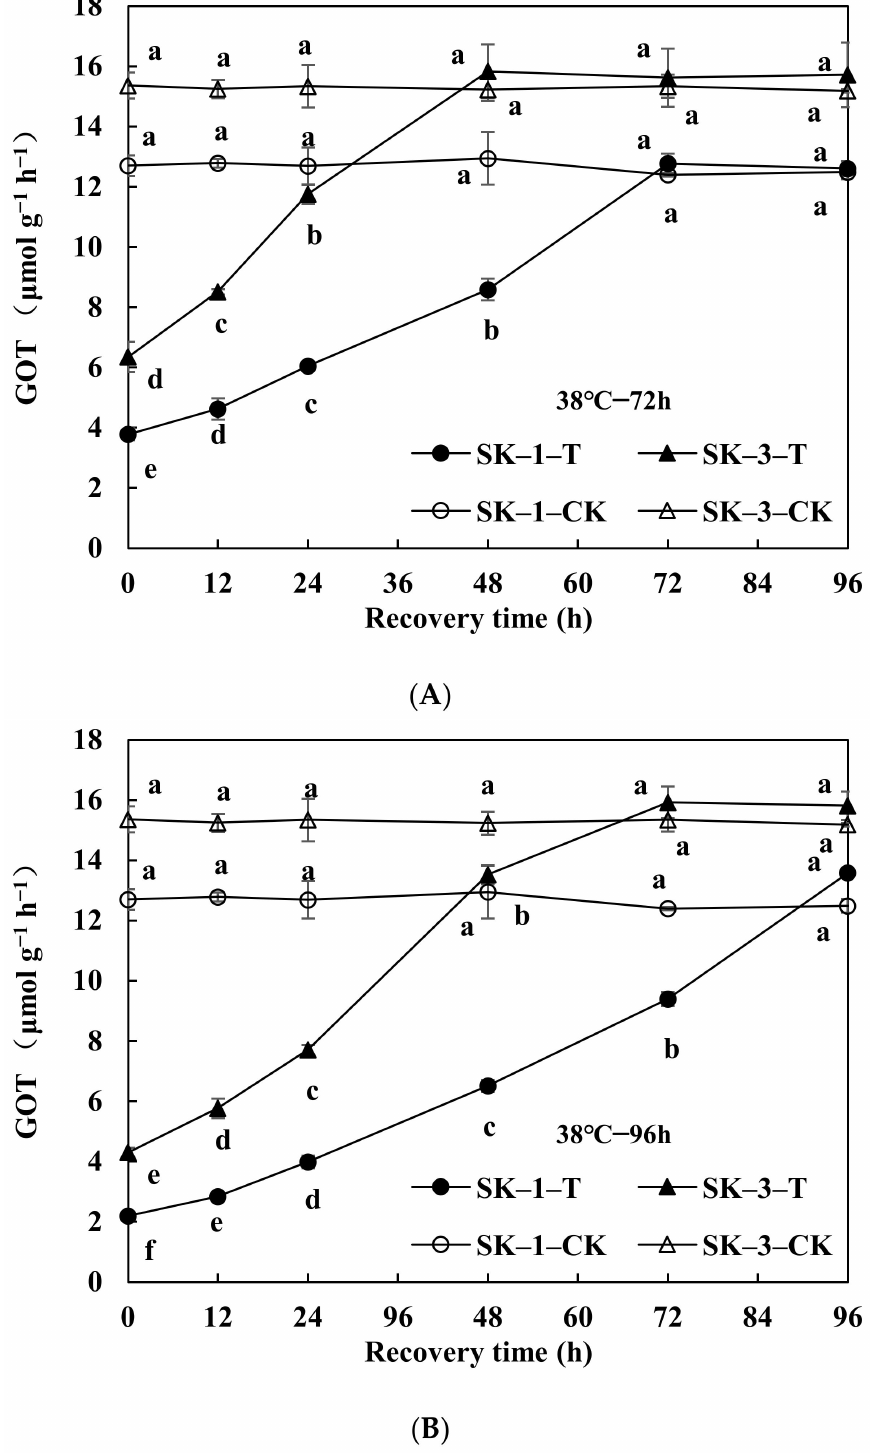
Figure 4. Changes in GOT activities in squares of Bt cotton after 72 h ( A ) and 96 h ( B ) high-temperature stress termination. GOT activity at the recovery time with different lowercase letters is significantly different from the control at p < 0.05 under the same high-temperature stress duration for the same cultivar. T—treatments for 72 h ( A ) and 96 h ( B );